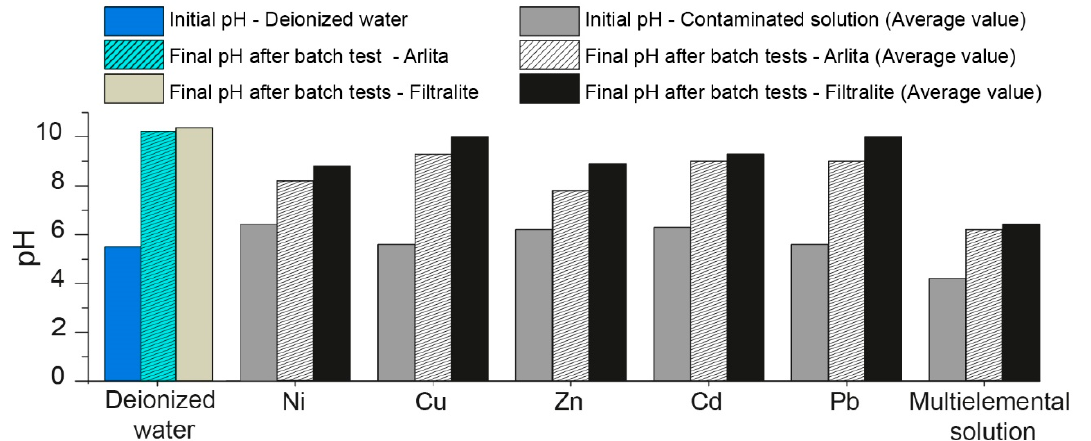
Figure 4. Initial and final average pH values for deionized water and contaminated solutions (individual or multiple contaminants) employed in the batch tests.